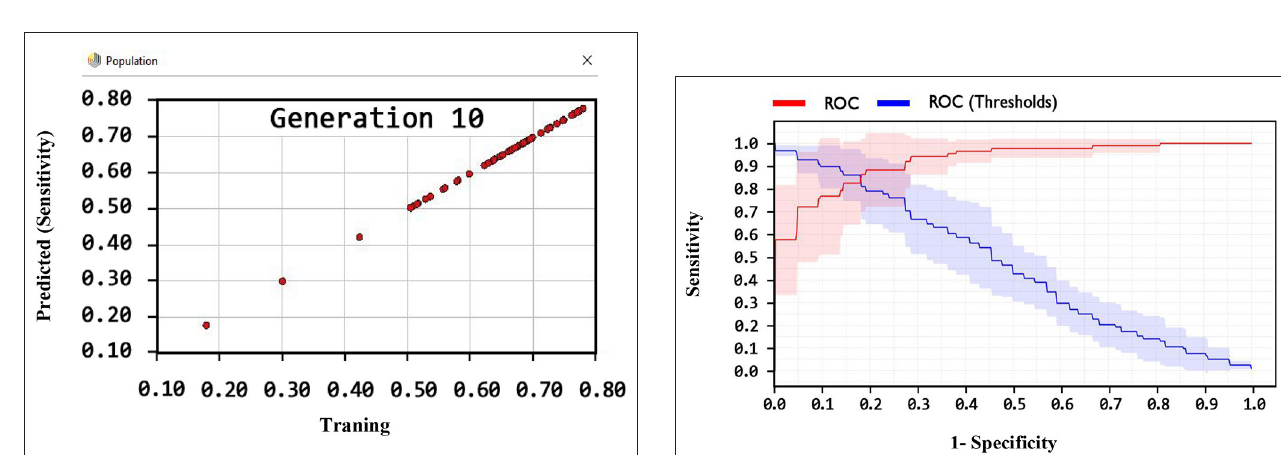
FIGURE 10 | ROC curve for LSVM